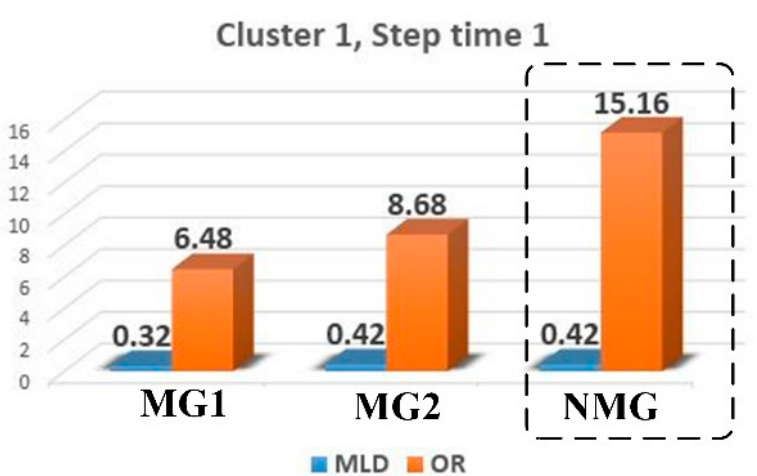
Figure 7. MLD and OR of MG1 and MG2 in individual and clustered operating mode.